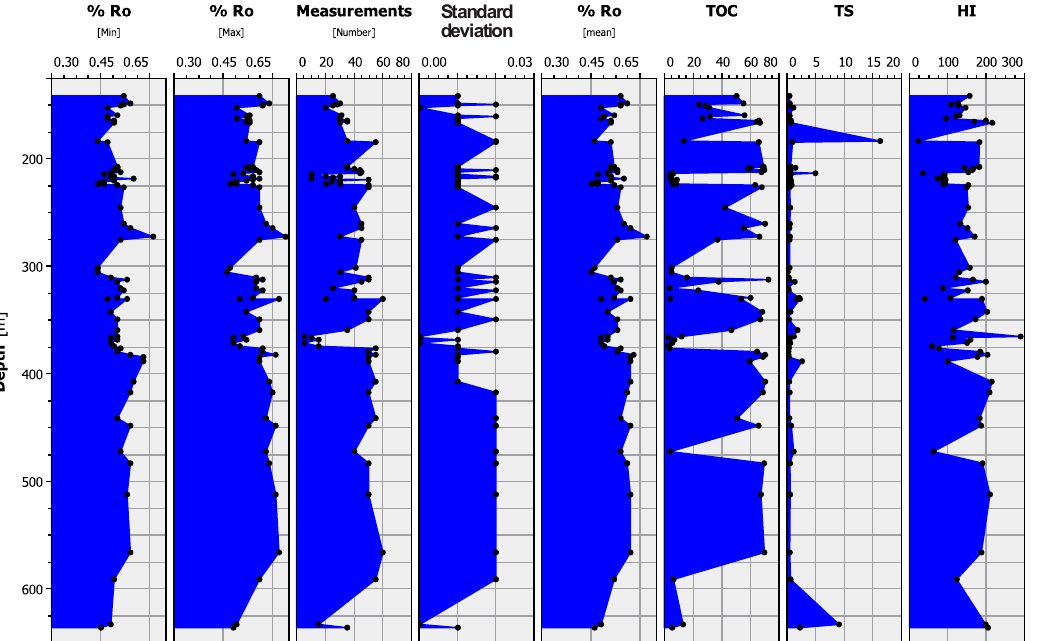
Figure 6. Graphic distribution of vitrinite reflectance analysis (%Ro), total organic carbon (TOC), total sulfur (TS), and hydrogen index (HI) of the Cerrej ó n Formation in the ANH-CARRETALITO-1 Well, see Supplementary Materials Table